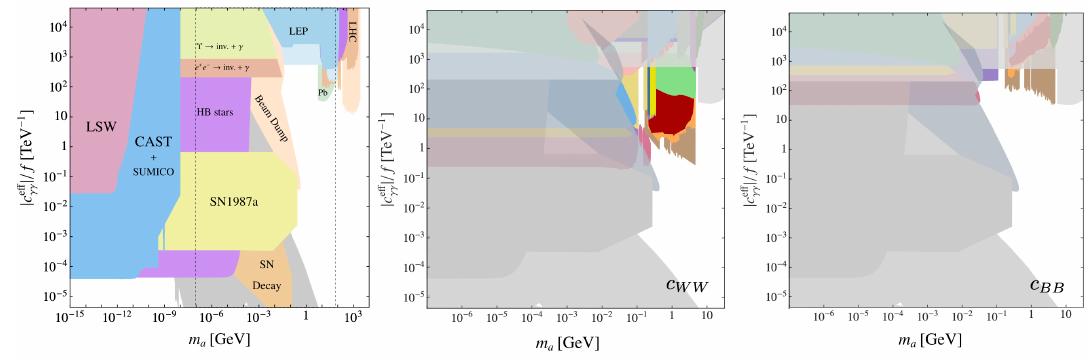
Figure 22 . Left: bounds on ALP couplings to photons [79]. The dashed contours indicate the part of the plot shown in various shades of gray in the center and right panels. Center and right: in color, we show flavor bounds on ALPs coupling only to SU(2) above) and the U(1) gauge boson (as in figure 21), respectively. They are compared to the gray Y astrophysical, beam dump and collider constraints on ALP couplings to photons with c eff (center) and c eff = c BB γγ